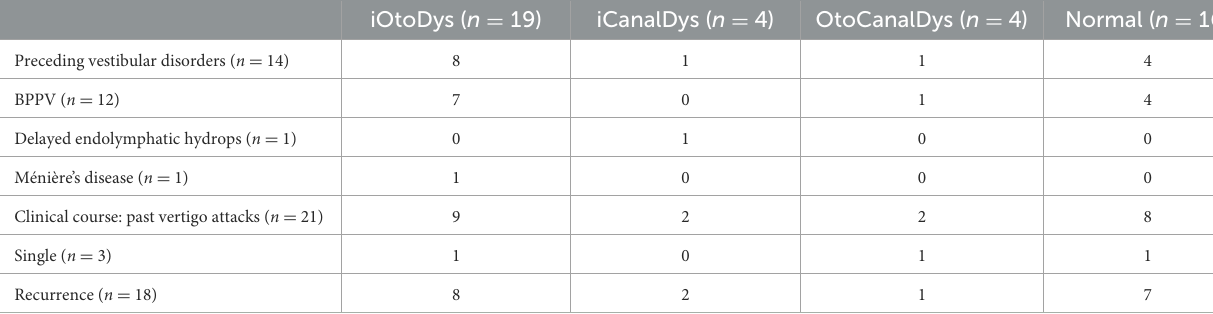
TABLE 1 Diagnosis of preceding vestibular disorders and vertigo attacks in patients with PPPD.